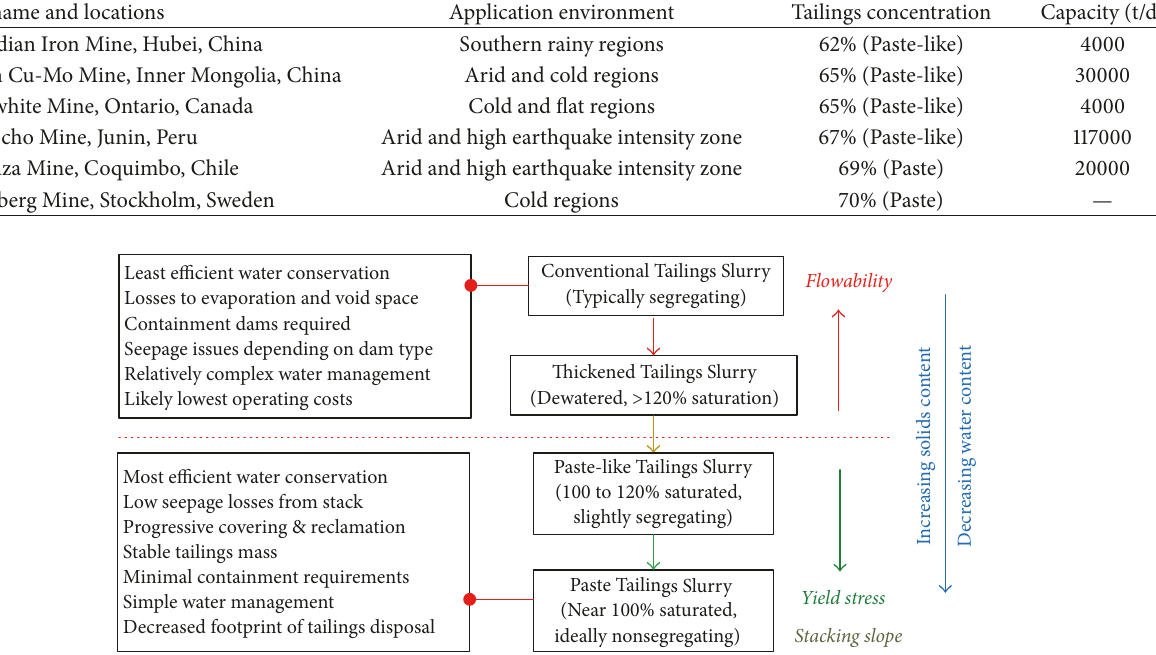
Table 1: Application examples of paste tailings disposal mines.